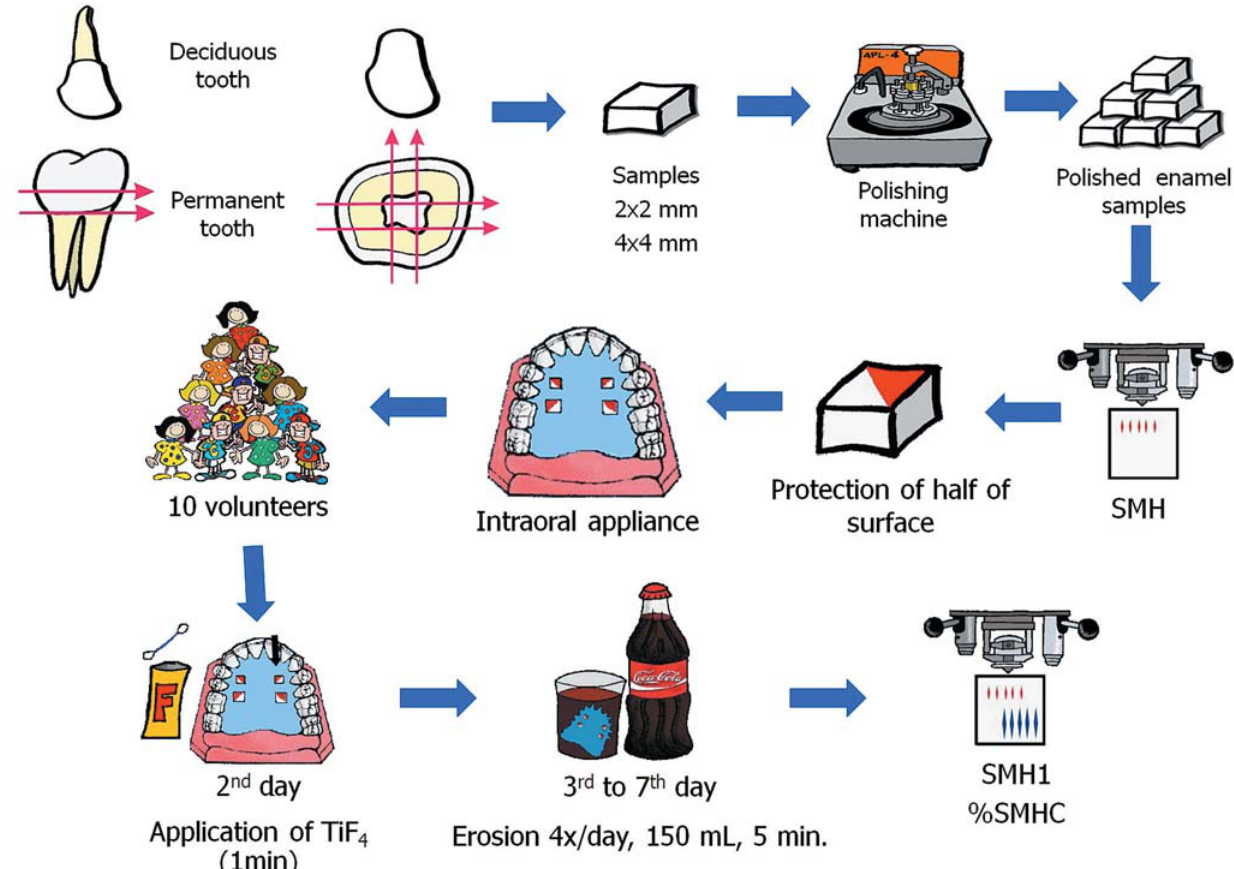
FIGURE 1- Experimental design of the